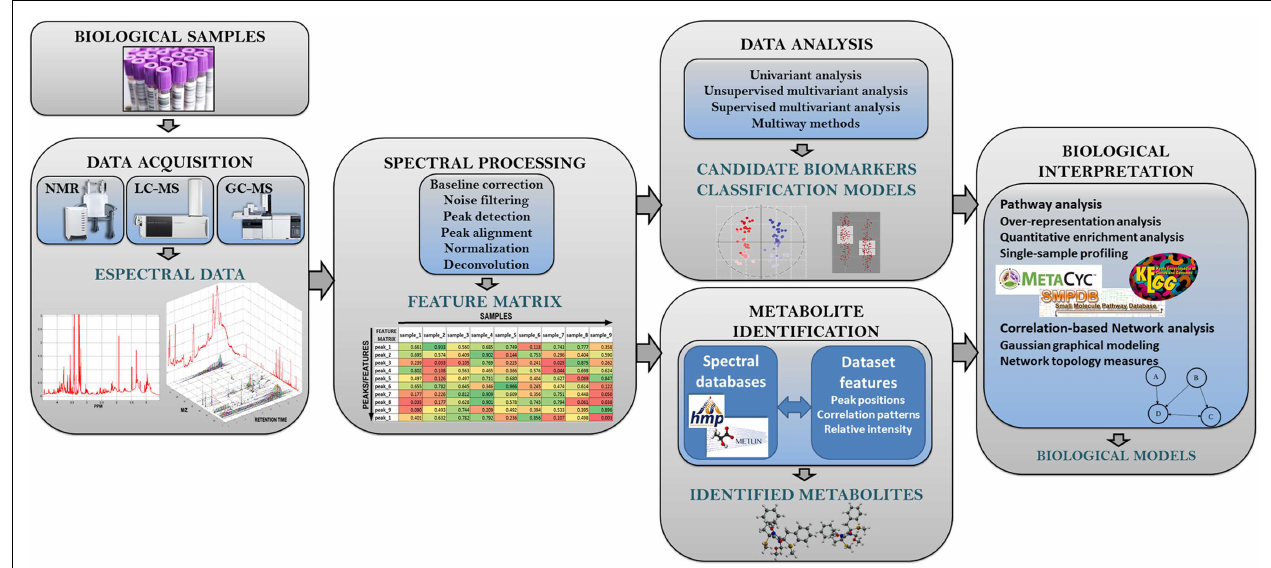
FIGURE 2 |Analysis workflow in untargeted metabolomic studies .This figure shows the different steps of the metabolomic analysis